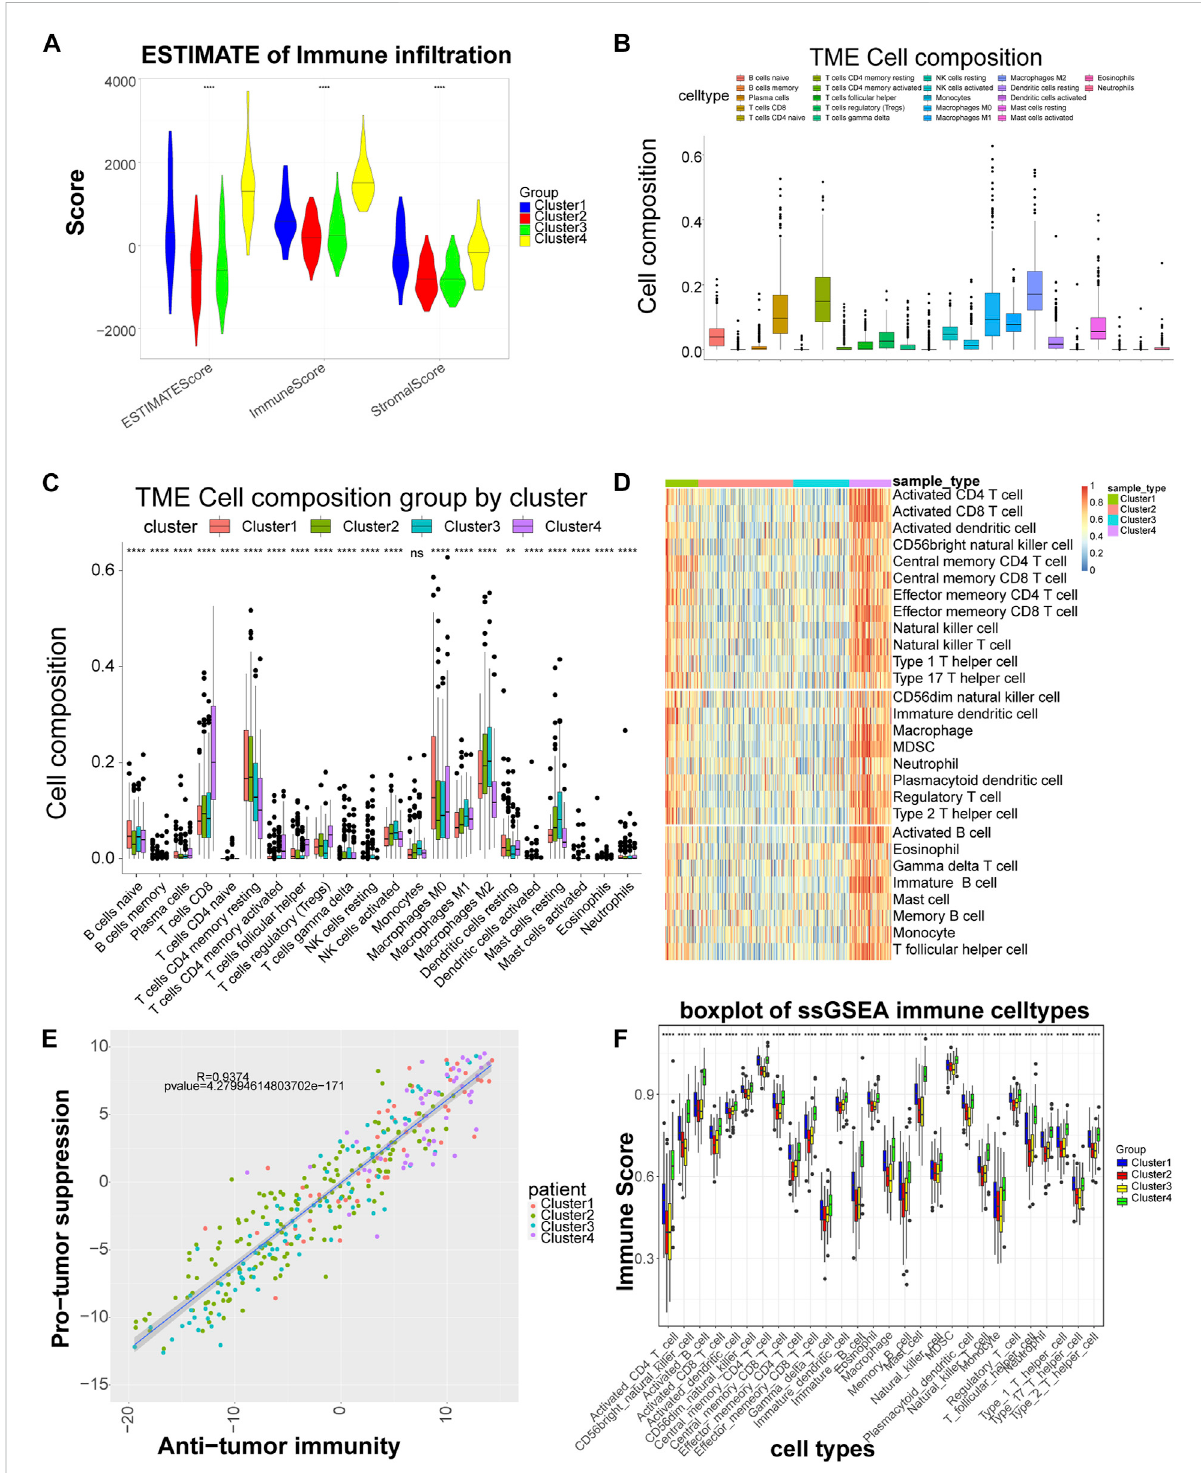
FIGURE 2 Signi fi cant differences in immune scores and immune cells among the different subtypes. (A) Distribution of the ESTIMATE score of each subtype. (B) Box plot of the proportional distribution of 22 immune cells in LIHC samples by CIBERSORT method. (C) Box plot of 22 immune cell distributionamongfoursubtypes .(D) HeatmapofimmunecelldistributionbyssGSEAmethod.Thehorizontalaxiscorrespondstodifferentsamples, and the vertical axis corresponds to different types of immune cells, with red representing high immunity and blue representing low immunity. (E) Correlation between tumor suppression and antitumor immunity. Anti-tumor immune score on the horizontal axis and anti-tumor score on the vertical axis. (F) Box plot of 28 immune cell among four subtypes. 28 cell types on the horizontal axis and immune scores on the vertical axis. **: p < 0.01,****: p < 0.0001, ns: no signi fi cant